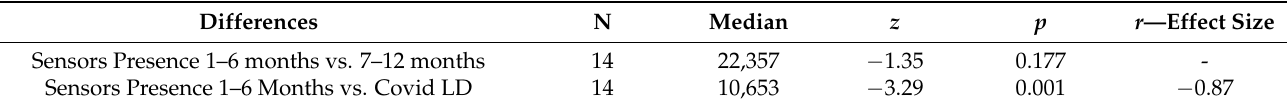
Table 3. Wilcoxon signed-rank test